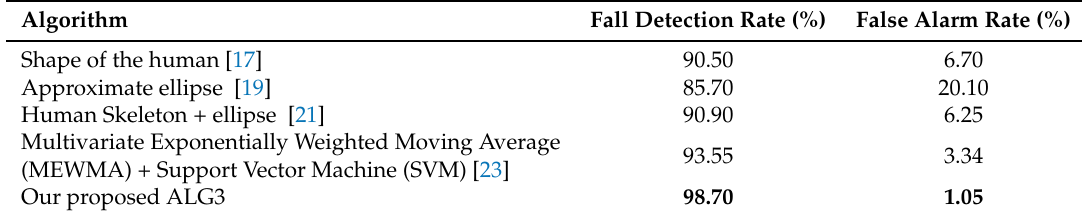
Table 5. Comparison of our proposed algorithm with four fall detection